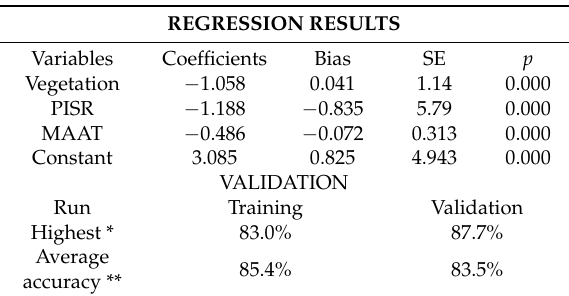
Table 5. Statistical coefficients and accuracy assessments for the